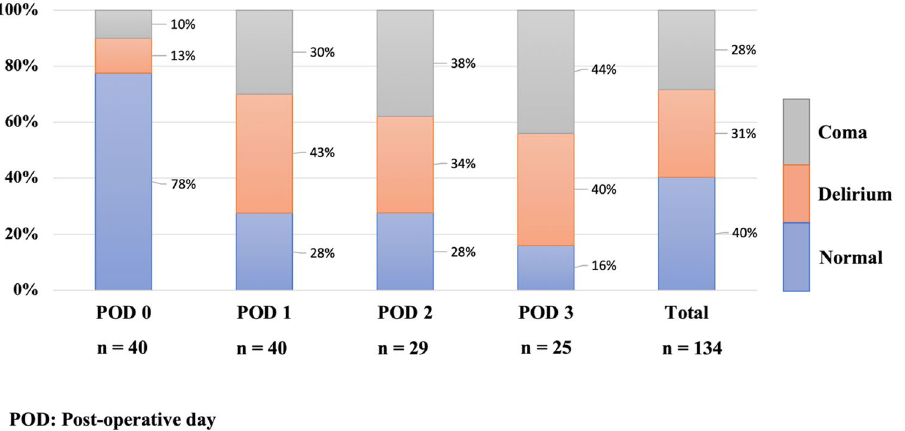
Figure 1. The distribution of post-operative normal, coma, and delirium states.